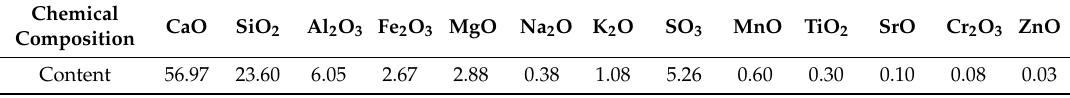
Table 1. Chemical composition of cement ( / wt%).